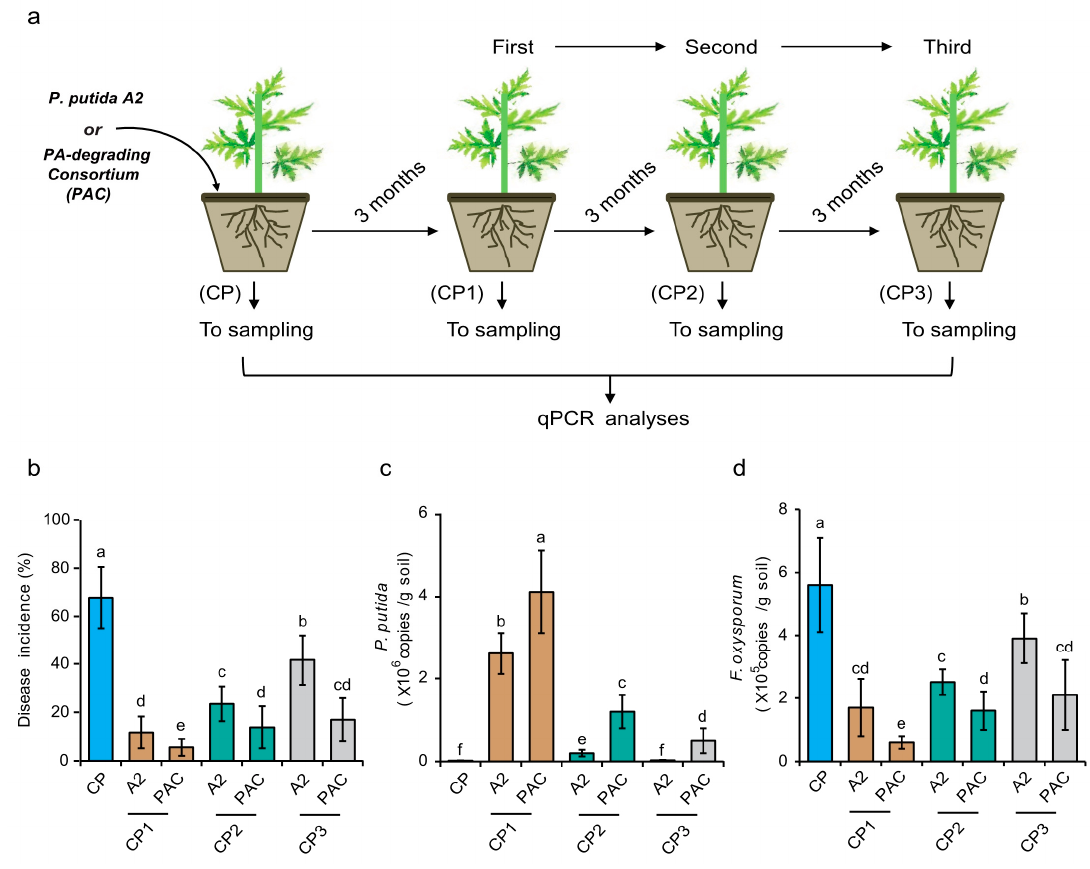
Figure 8. E ff ects of P. putida A2 or a PA-degrading consortium (PAC) on disease incidence in the 15-year conducive soils (Con15). ( a ) Experimental scheme for pot designs. P. putida A2 at 2 × 10 7 CFU / g or PAC harboring P. putida A2 (2 × 10 7 CFU / g), Xanthomonas sp. NC8 (5 × 10 6 CFU / g) and Rhizobium sp. HU16 (5 × 10 6 CFU / g) was poured into the base of three-week-old Chrysanthemum seedlings, grown in the 15-year conducive soils. After three months, three-week-old seedlings were subjected to the second and third successive plantings (cycles) into the same pots. Disease incidence ( b ), A2 growth ( c ), and Fusarium density ( d ) were determined in the rhizosphere soils. CP, consecutive planting (non-treated Con15); the A2- or PAC-treated soils were subjected to first (CP1), second (CP2) and third (CP3) three-month planting. Data are means ± SE. Di ff erent letters above the bars indicate statistically significant di ff erences by Tukey’s HSD test.